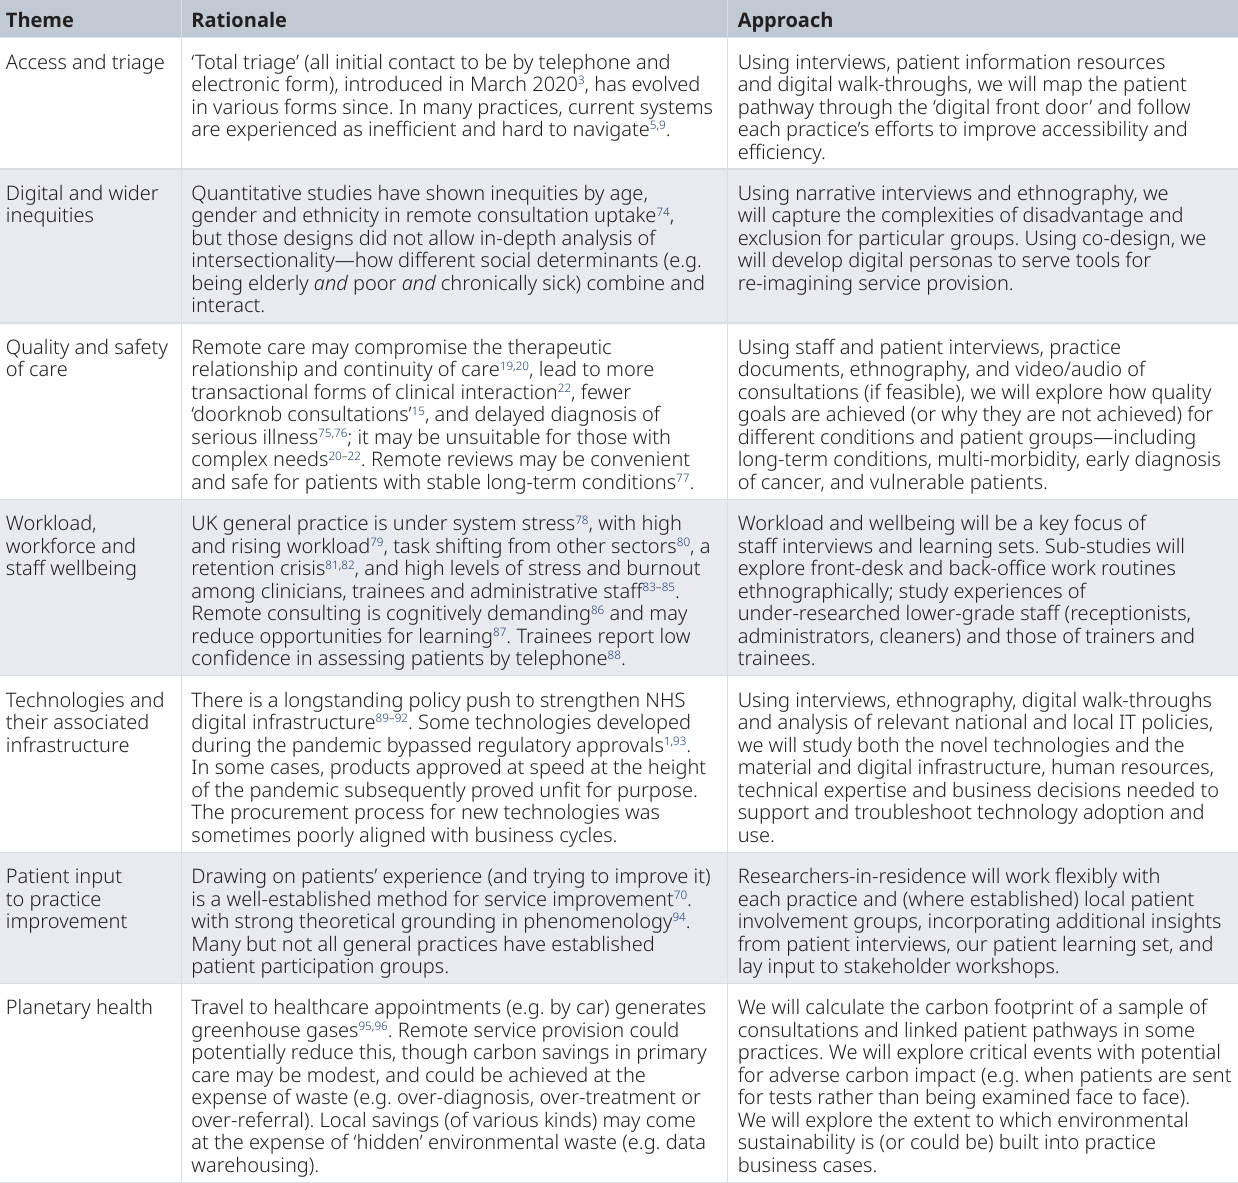
Table 3. Cross-cutting themes to be explored across 11 general